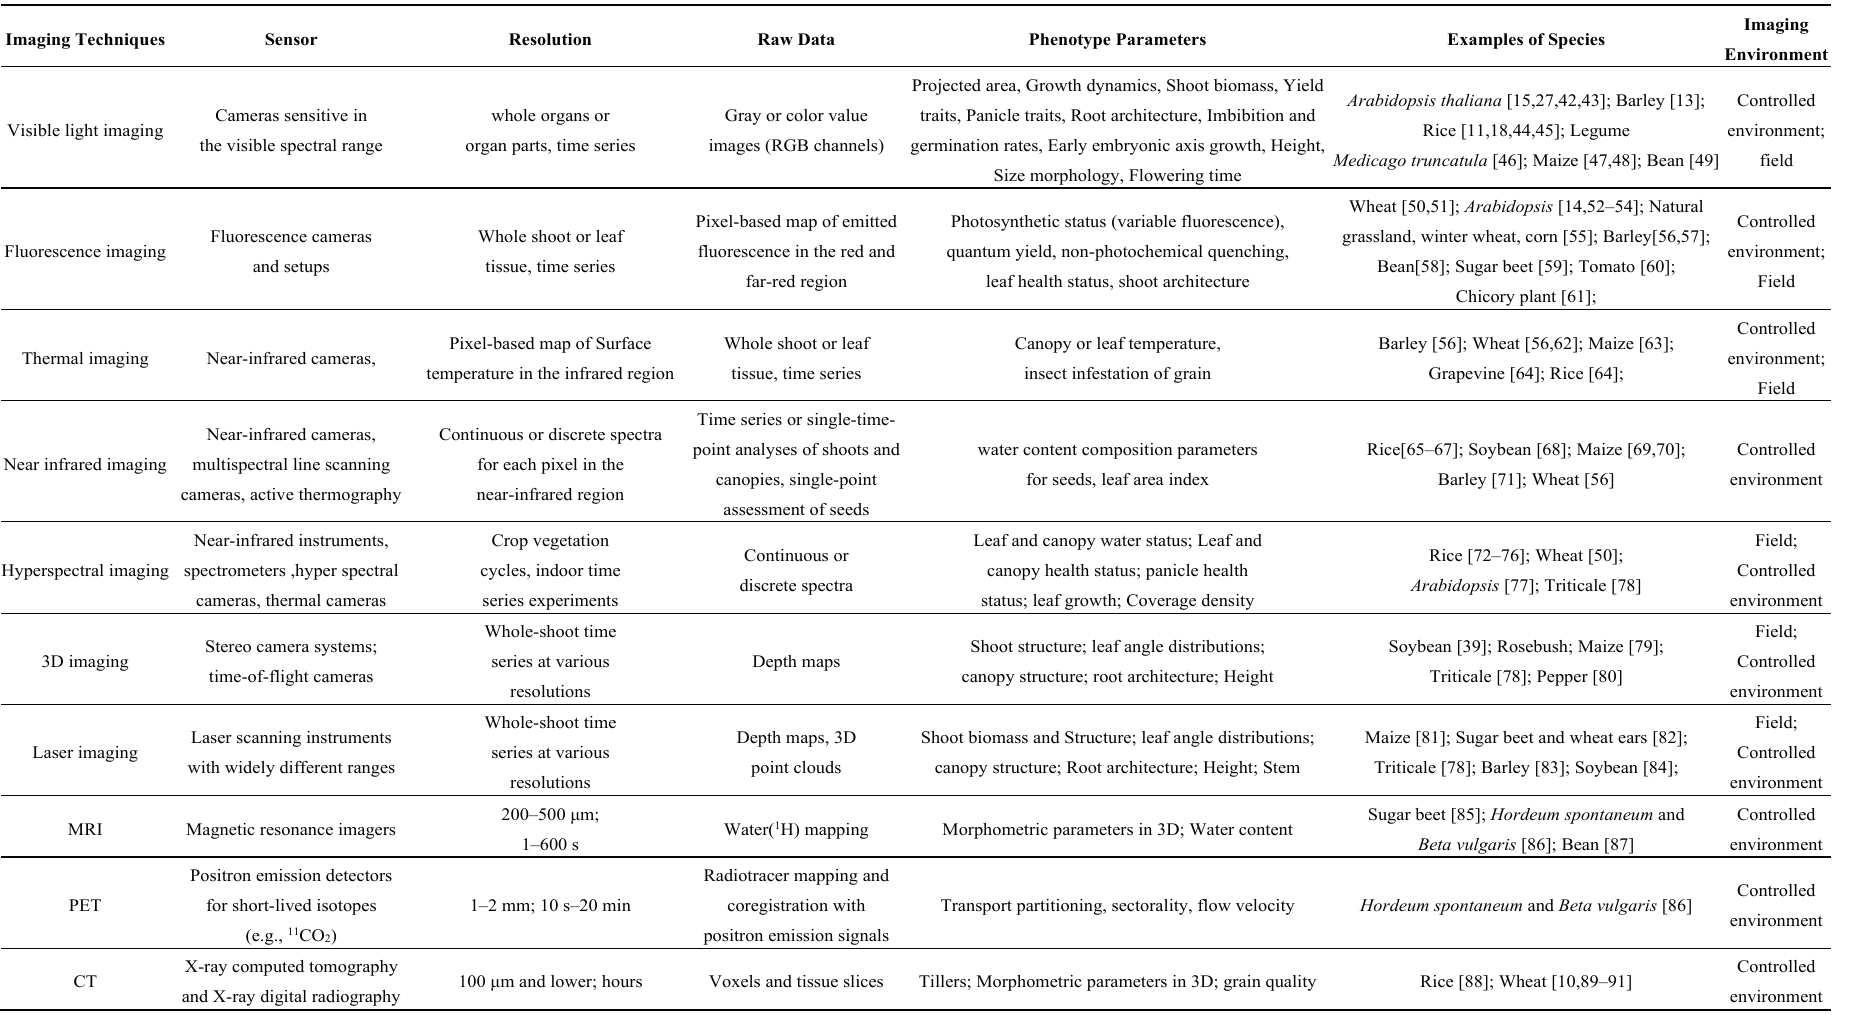
Table 1. A comparison of different imaging techniques in plant phenotype application